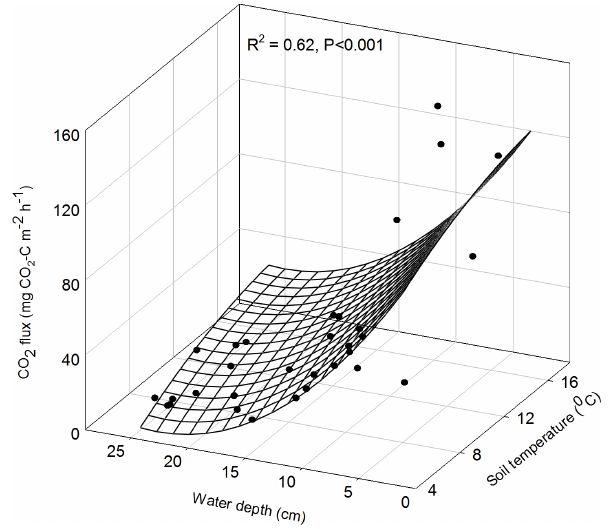
Figure 8. Dependence of CO 2 fluxes on water depth and soil tem- perature during the intervals in which the LFS is flooded. A signifi- cant ( R 2 = 0 . 62, P < 0 . 001) 3-D paraboloid regression is shown in the mesh plot. Individual values shown are means ( n =